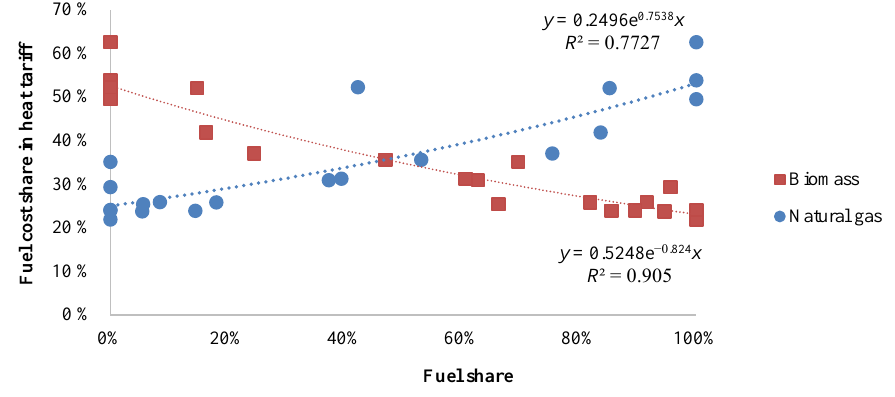
Fig. 6. Fuel cost share in heat tariff dependence on natural gas and biomass share in heat